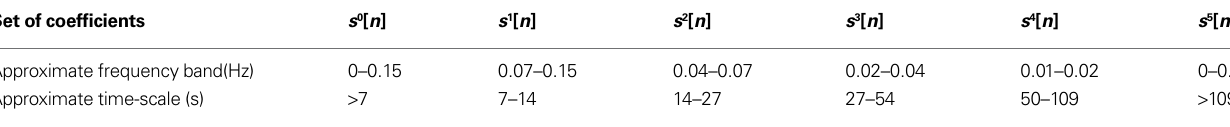
Table 1 | The frequency characteristics of the constructed wavelet fi lter